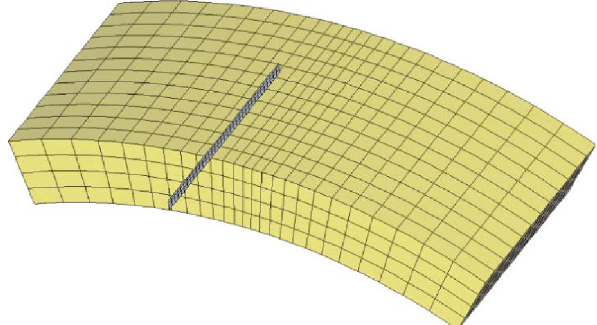
Figure 9: Numerical model for the tunnel lining segment with initial surface crack.